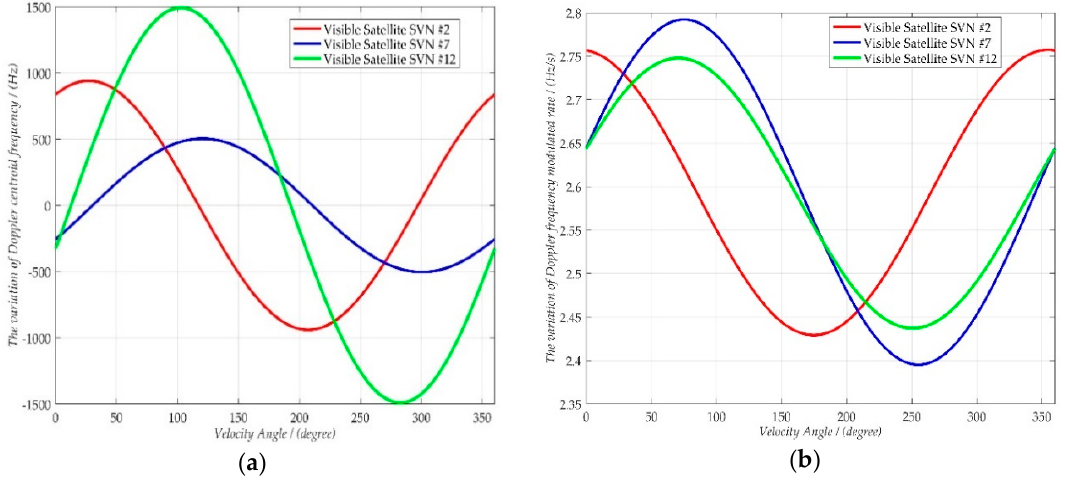
Figure 2. Variations of f d , v and f r , v caused by air target motion with 220 m/s in different geometric configurations (the X-axis is the angle between the target velocity and the Y-axis). ( a ) Variation of f d , v ( b ) Variation of f r , v .